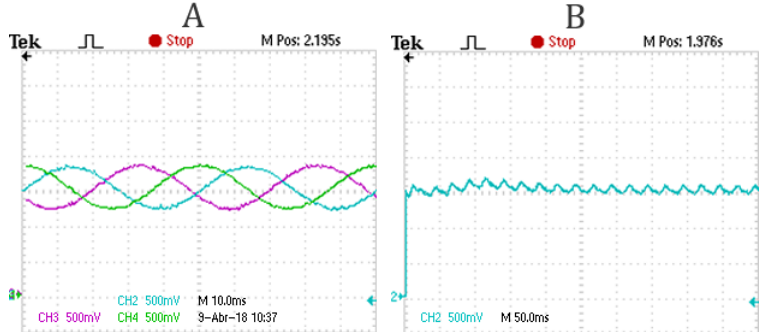
Figure A4. SHIL experimental result of 3-phase boost converter). Input voltage (( A ): E a —blue, E a —magenta, E c —green) and normalized output voltage x 2 (1.5 V DAC output voltage correspond to V d = 200 V) using nonlinear control (A39-19)—( B